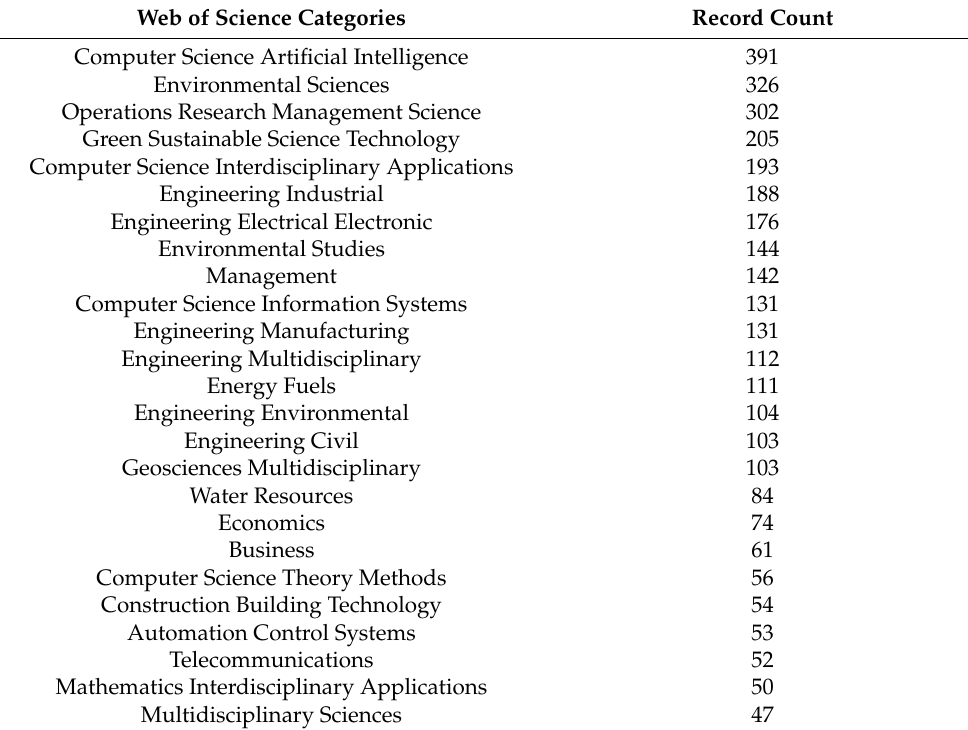
Figure 2. Articles publication trend for the period 1994–2022. Table 1. Top 25 Web of Science categories.